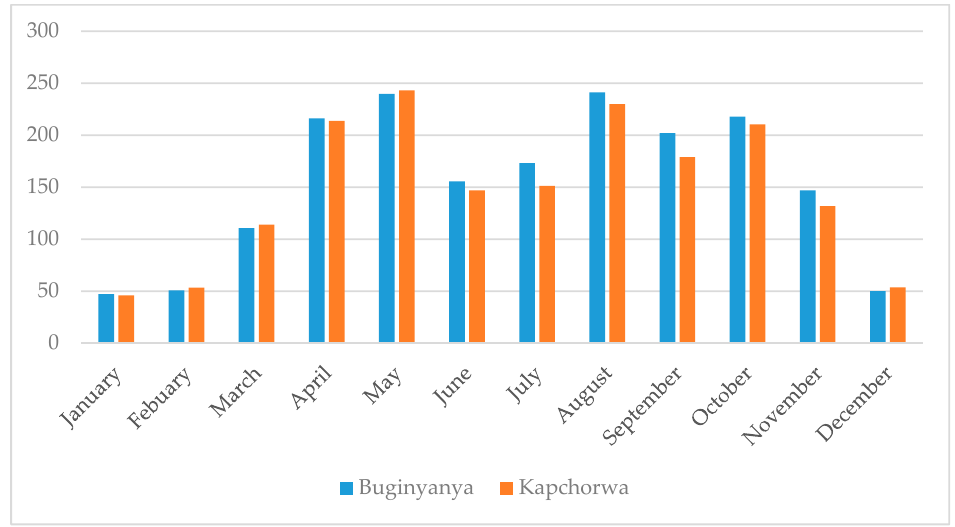
Figure 2. Monthly mean rainfall in Buginyanya and Kapchorwa weather stations (1981–2015).